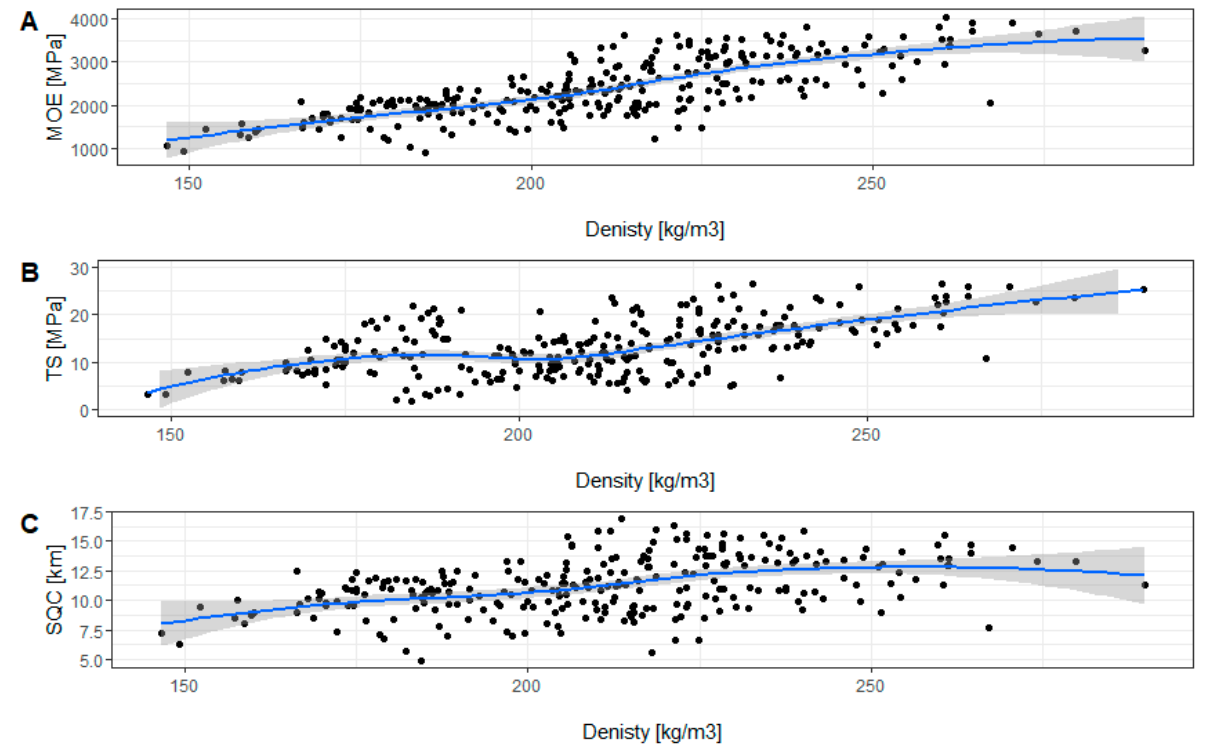
Figure 7. Correlation of density with the modulus of elasticity ( A ), tensile strength ( B ), and strength- to-density coefficient ( C ) for all collected samples. Table 7. Pearson correlation of examined properties from the ground section: density, modulus of elasticity, tensile strength, and strength-to-density coefficient.